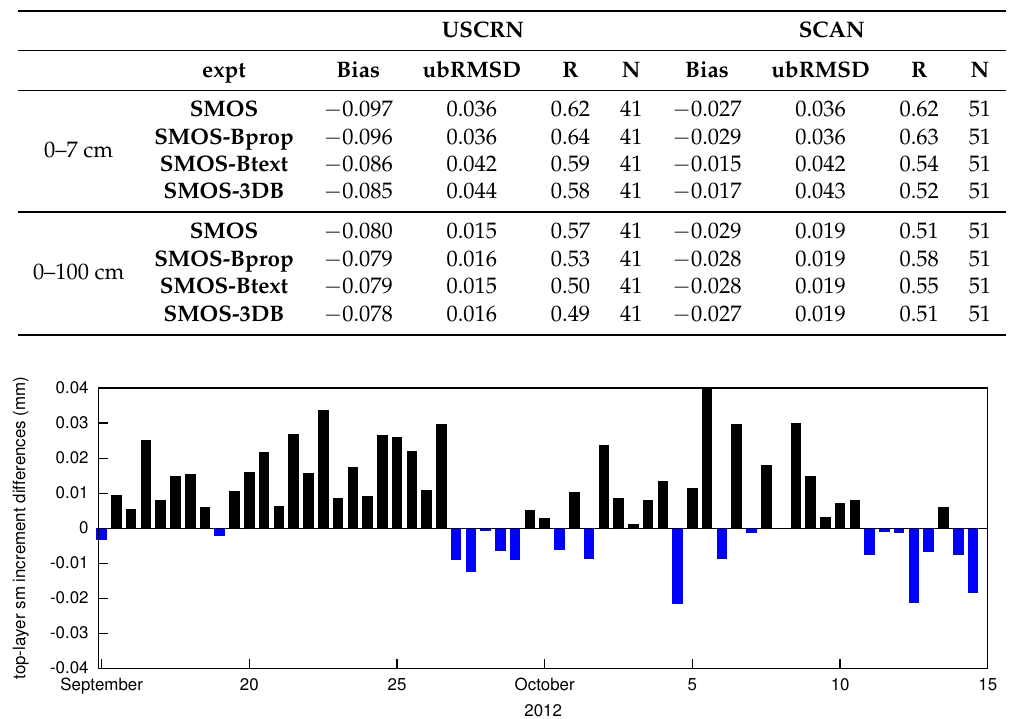
Figure 5. Top soil moisture increment differences (in mm of water) averaged over the North America region. Differences shown are SMOS – SMOS-Bprop